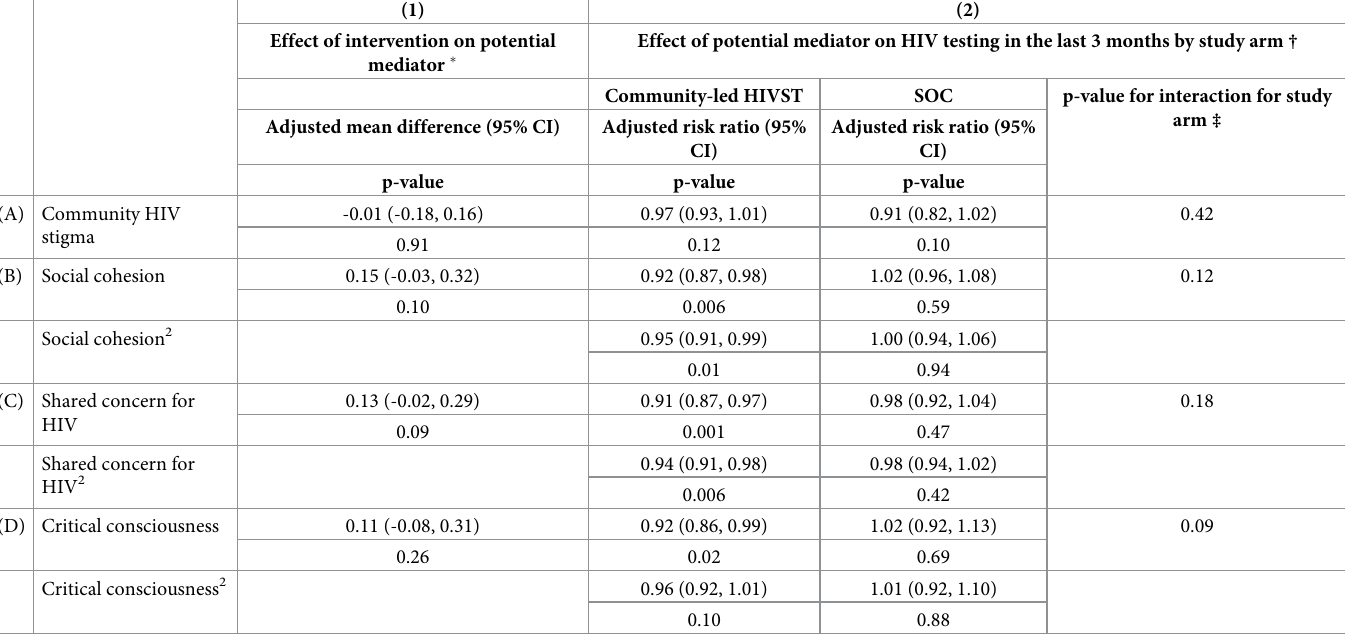
Table 2. Effect of community-led HIV self-testing intervention and potential